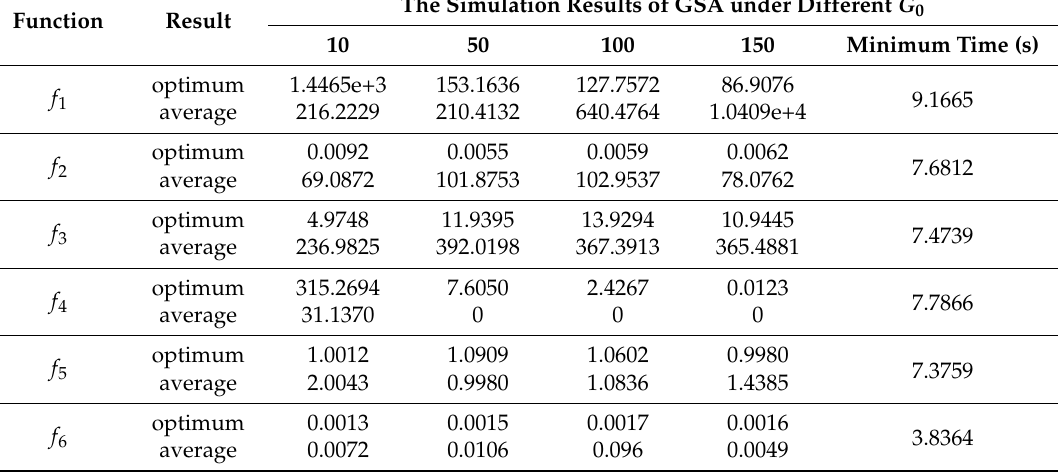
Table 2. The simulation result of different number of G 0